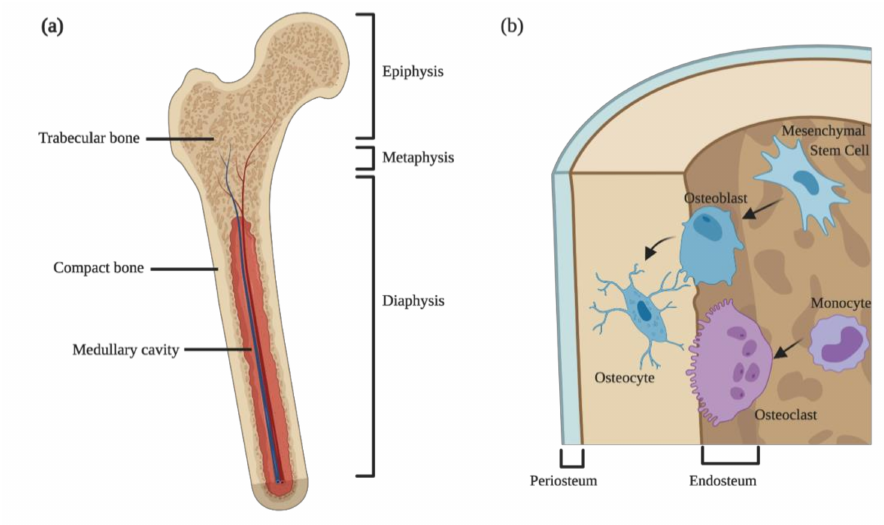
Figure 1. Bone structure and cellular components. ( a ) Anatomical division and types of bone present in long bones; ( b ) cellular components of bone and their cellular precursors. Osteoblasts are derived from mesenchymal stem cells and form new bones by the deposition of extracellular and mineral matrix. When osteoblasts become entrapped in the newly formed bone, they mature into osteocytes. Bone degradation is accomplished by large multinucleated cells, the osteoclasts, which have a myeloid